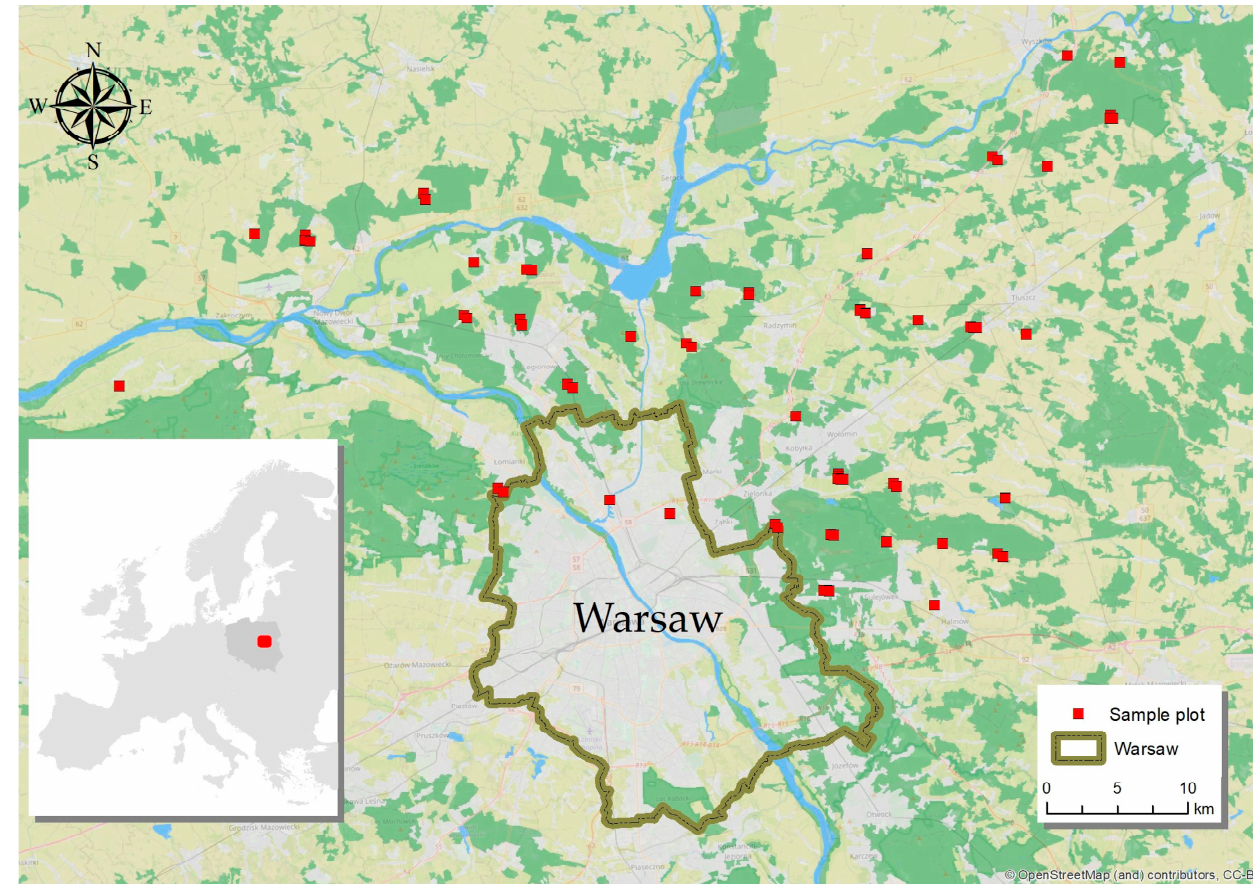
Figure 1. Location of sample plots around the capital of Poland—Warsaw. Table 1. Detailed characteristics of the main types of stands occurring on the study plots. Stand Type Pine Birch Oak